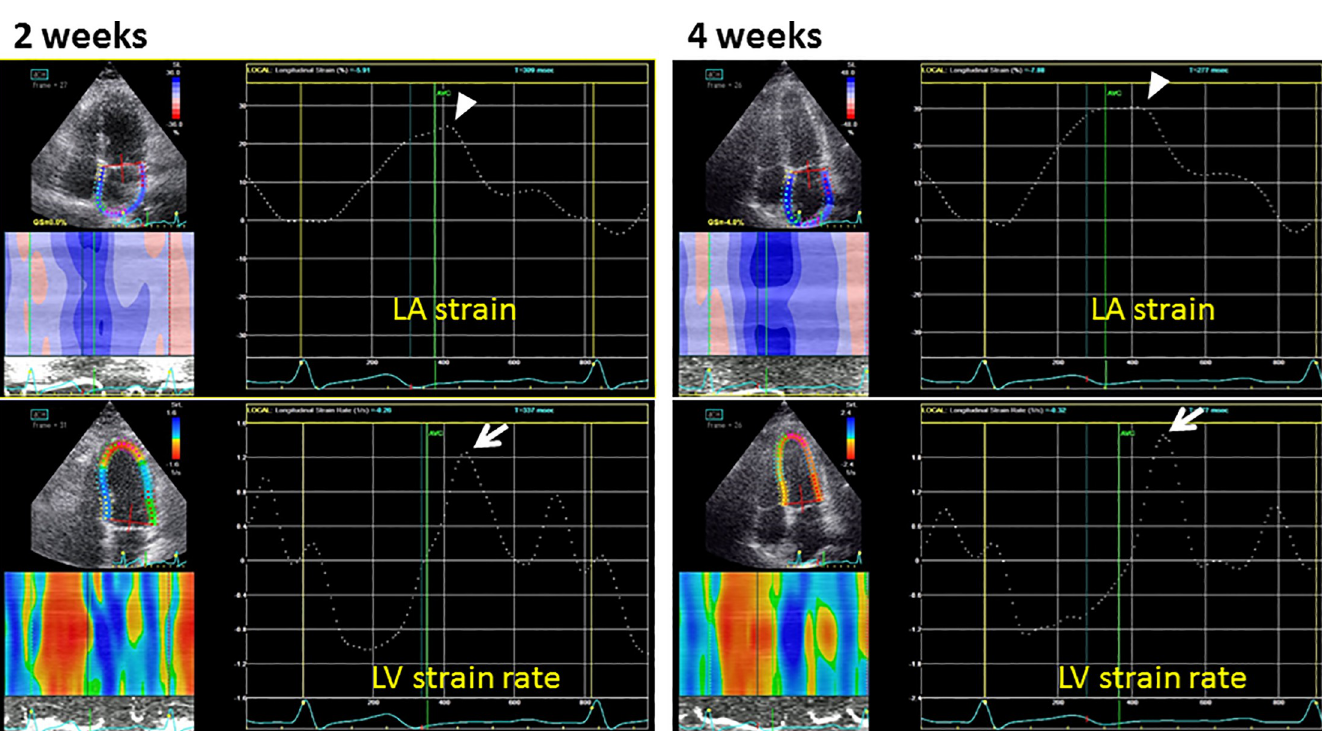
Fig 6. Strain and strain rate curves for the LA (top) and LV (bottom) to assess LA strain (arrows) and e’sr (arrow heads), respectively, for the patient as in Fig 3.